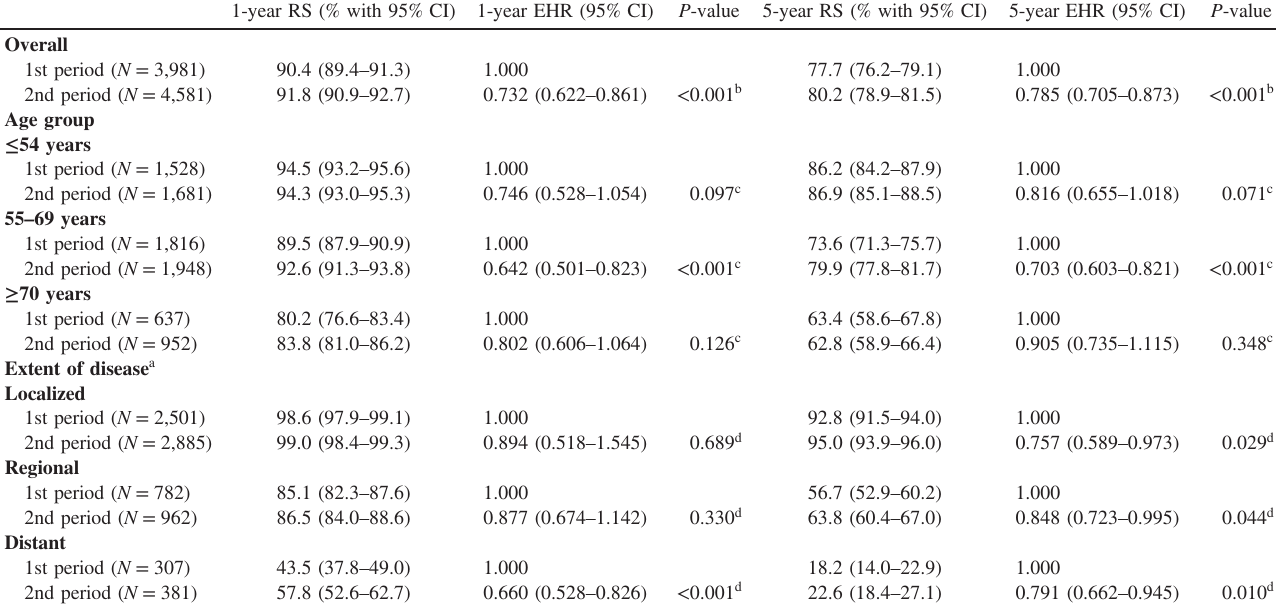
Table 2. Relative survival rates and estimated excess hazard ratios for cancer of the corpus uteri, 1st period (1993 – 2000) and 2nd period (2001 –